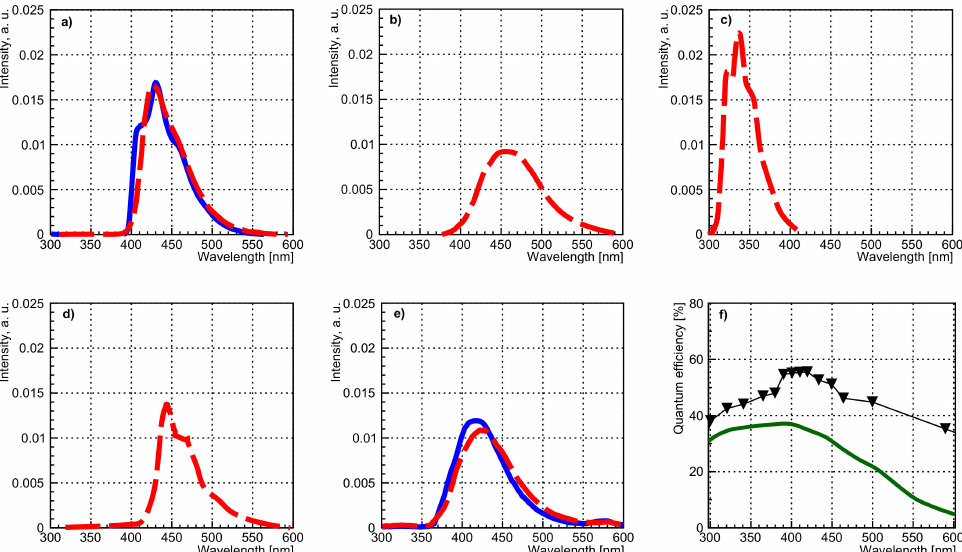
Figure 3. Emission spectra of wavelength shifters relevant for liquid argon detectors, area normalized, and quantum efficiency curves of photosensors. Spectra measured at room temperature are shown (red, dashed lines) and, when available, also at 87 K (blue solid lines). ( a ) 1,1,4,4-tetraphenyl- 1,3-butadiene (TPB) [36], ( b ) pyrene [30], ( c ) p-terphenyl [37], ( d ) 1,4-Bis(2-methylstyryl)benzene (bis-MSB) [28], ( e ) polyethylene naphthalate (PEN) [38]. ( f ) Quantum efficiency curves at room temperature for FBK NUV-HD-SF SiPMs at 10 V overvoltage (black triangles) [5] and Hamamatsu R11065 PMTs (green solid line)